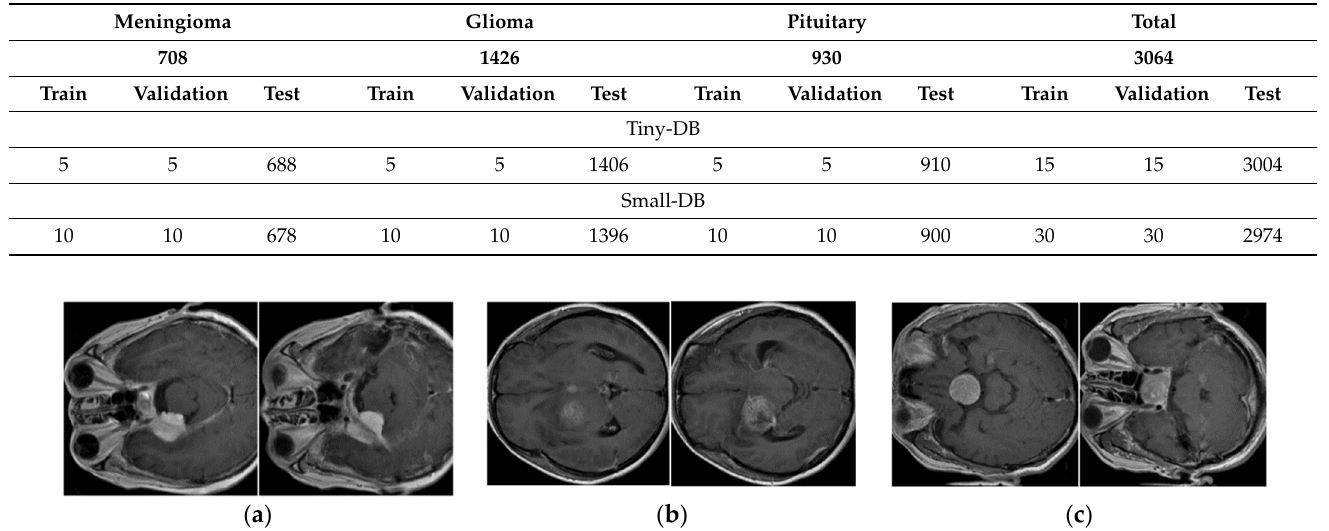
Table 5. Summary of images in the BT-Large dataset.